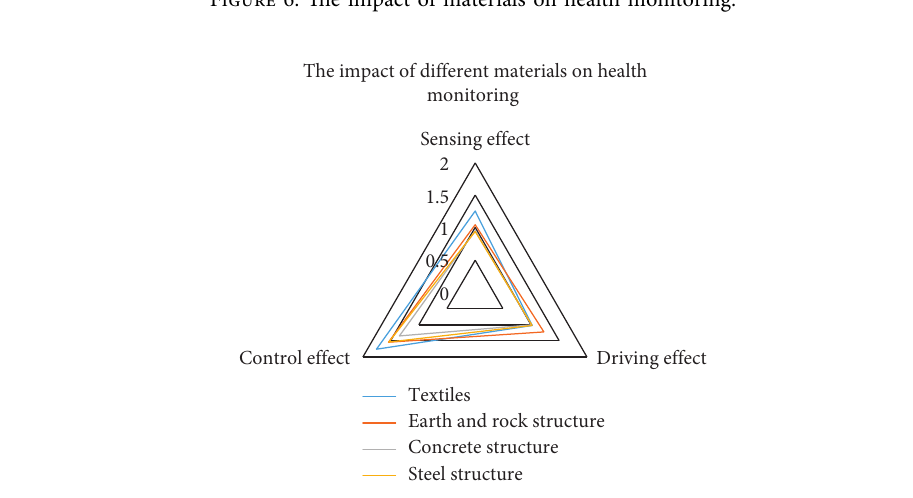
Figure 7: The impact of different materials on health monitoring. Table 4: Antidamage